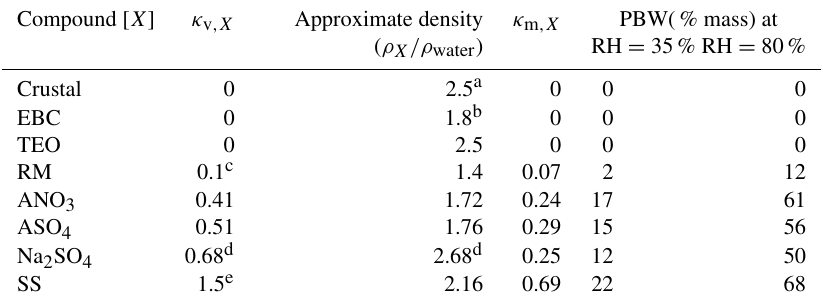
Table 2. The κ -Kohler constants for volume ( κ v ) , mass ( κ m ) , and related quantities. Compound [ X ] κ v ,X Approximate density κ m ,X PBW(% mass) at ( ρ X /ρ water ) RH = 35% RH = 80% Crustal 0 2.5 a 0 0 0 EBC 0 1.8 b 0 0 0 TEO 0 2.5 0 0 0 RM 0.1 c 1.4 0.07 2 12 ANO 3 0.41 1.72 0.24 17 61 ASO 4 0.51 1.76 0.29 15 56 Na 2 SO 4 0.68 d 2.68 d 0.25 12 50 SS 1.5 e 2.16 0.69 22